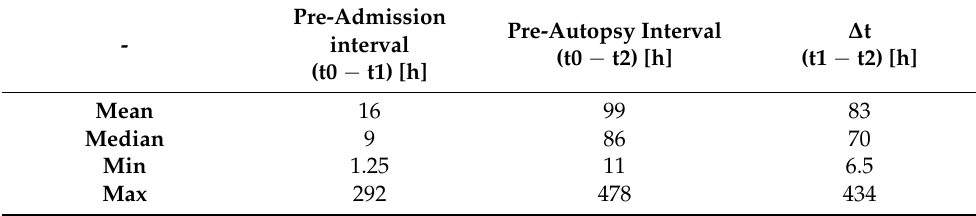
Table 1. Summary of time-intervals between estimated time of death and sampling